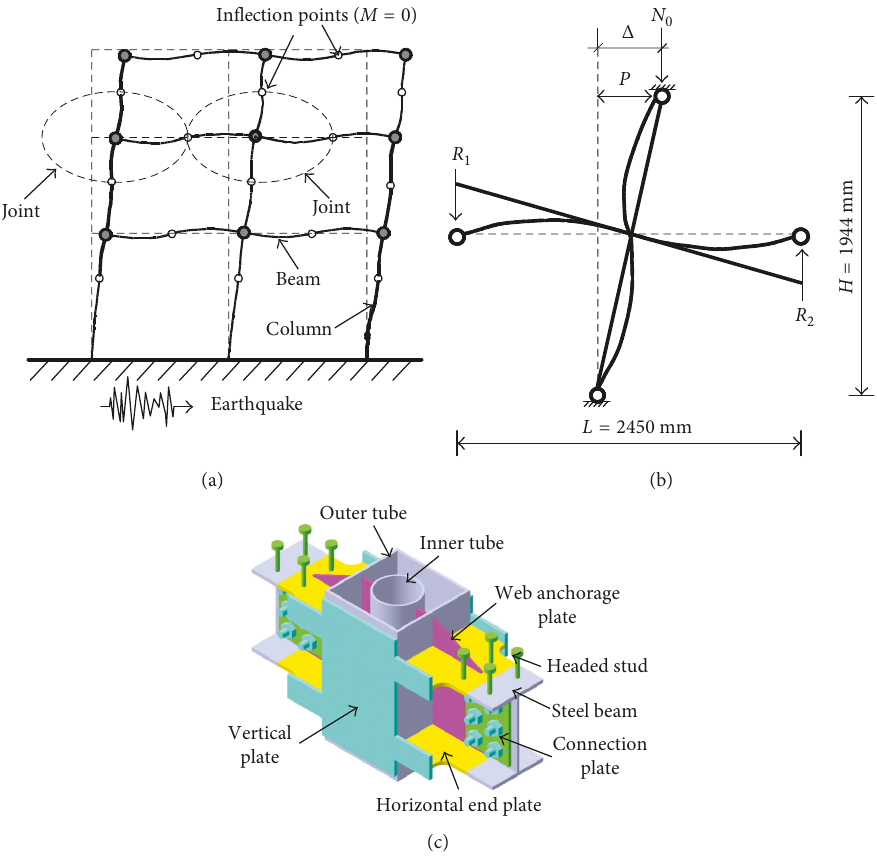
Figure 1: Schematic views of the joint model. (a) Frame. (b) Joint model. (c) Construction of the composite joint